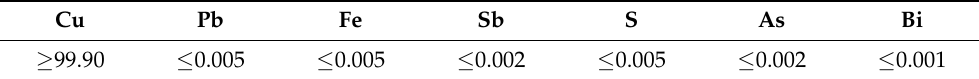
Table 1. Chemical composition of the cold-rolled Cu foils (wt.%).